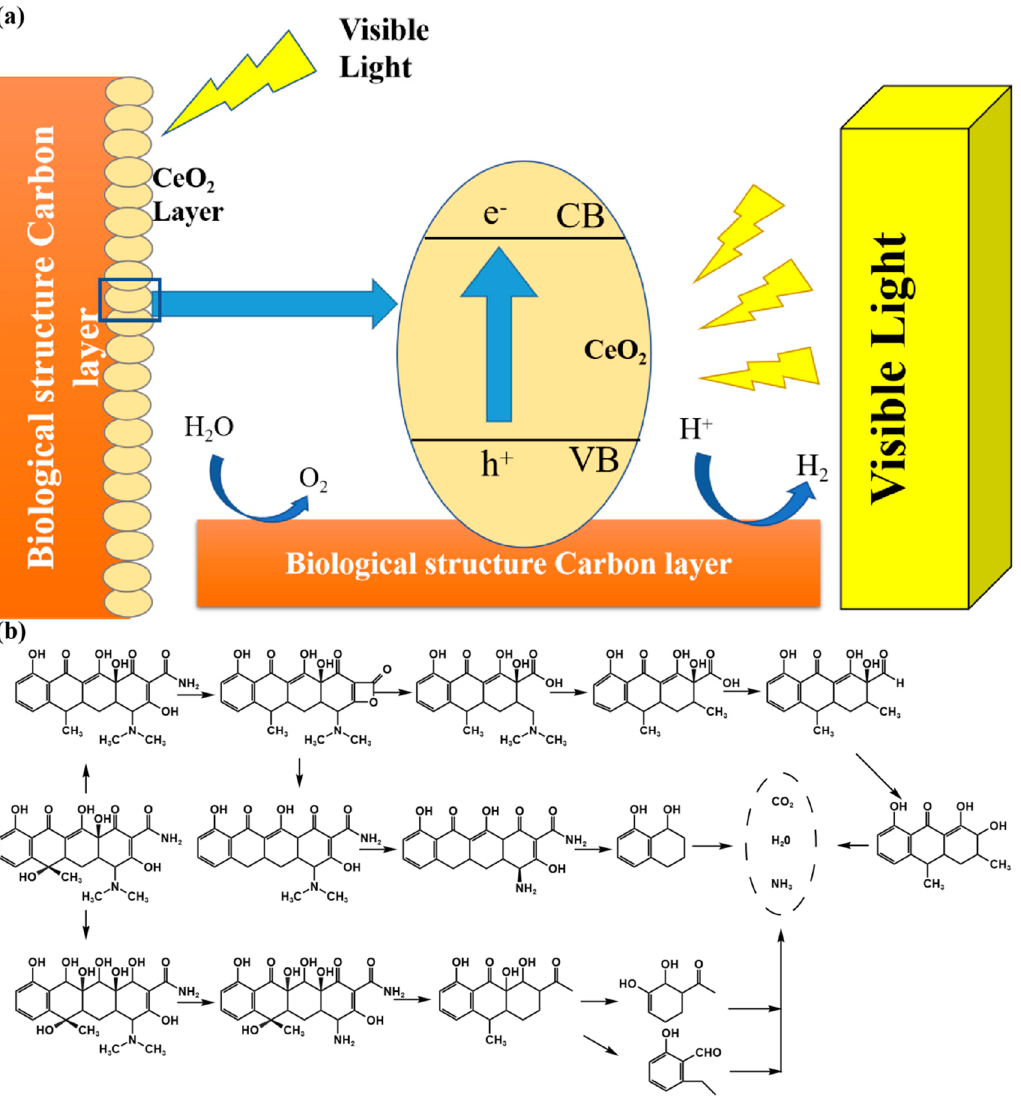
Figure 9. ( a ) 600 Ce-SPC diagram of photocatalytic mechanism. ( b ) Possible degradation pathways of TC in sample 600 Ce-SPC photocatalytic system.